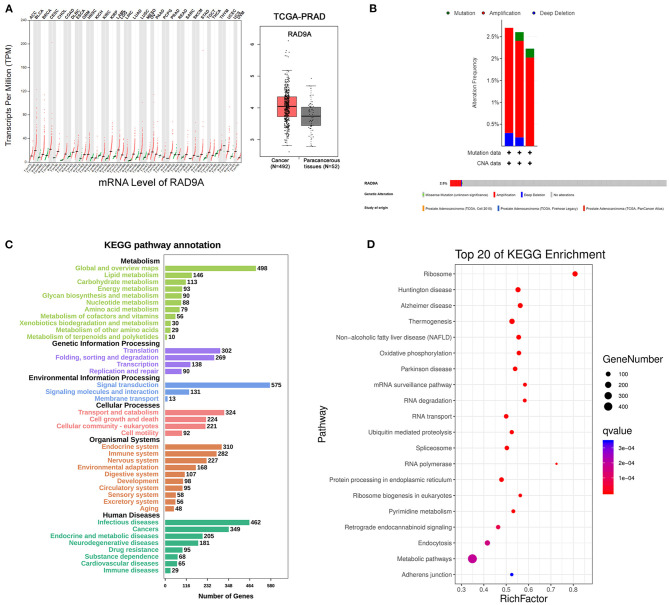
RAD9A gene expression and mutation analysis in prostate cancer. (A) The scatter of RAD9A expression levels in cancers from GEPIA (left), the boxplot of RAD9A expression levels in prostate cancer from TCGA (right). (B) Alteration frequency and genetic alteration analysis in prostate cancer by cBioPortal. (C,D) The top 20 pathways of KEGG pathway analysis, the input genes are related with RAD9A expression (Q-value < 0.01, r > 0.3, or r < −0.3) from the TCGA dataset. The size of the bubble represents the gene number, and the color indicates the Q-value.